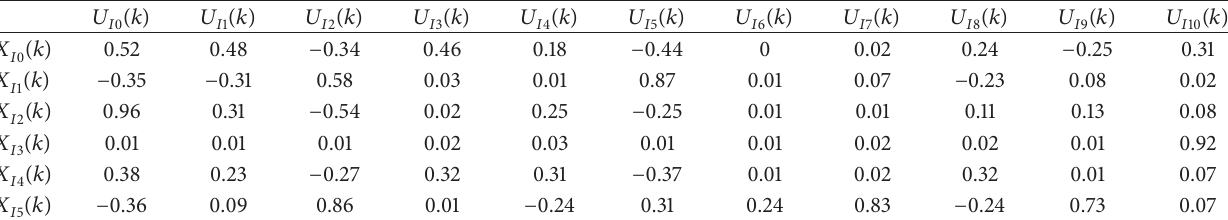
of the sensitivity of conscious reaction. OM